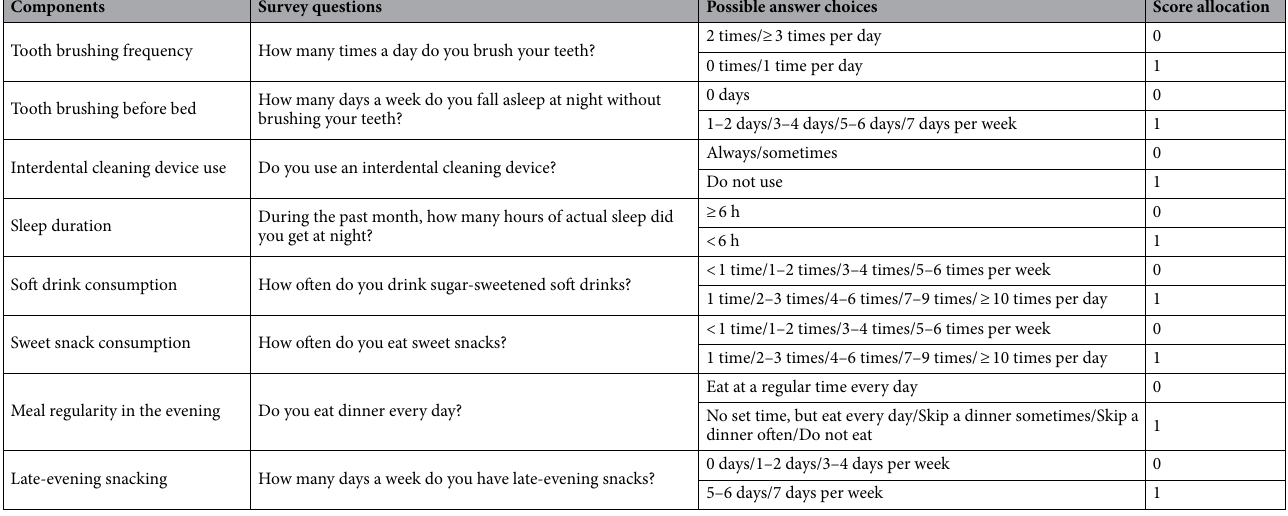
Table 4. Unhealthy lifestyle behavior index